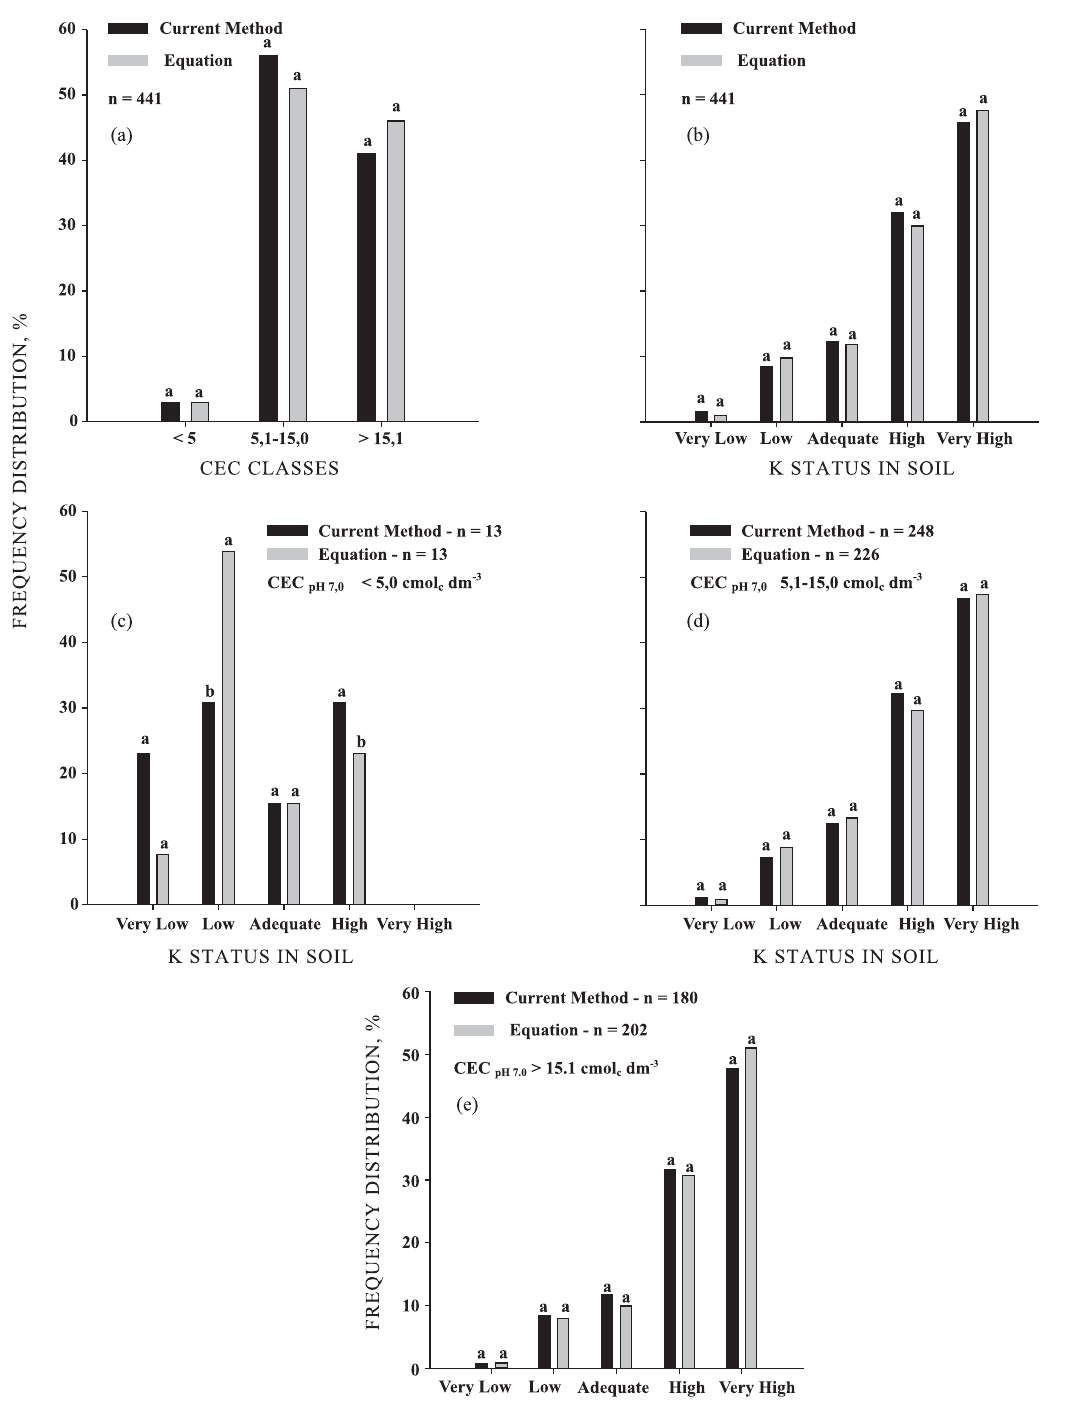
Figure 4. Frequency histogram of the samples used in this work; (a) CEC classes; (b) K status in soil including all CEC classes; (c) K status in soil CEC < 5.0 cmol dm -3 ; (d) K status in soil CEC 5.1-15.0 cmol c K status in soil CEC > 15.1 cmol dm -3 . Freequencies followed by the same letters in each class do not c differ statically by paired t-test (p <